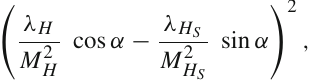
¯ f , where f is the